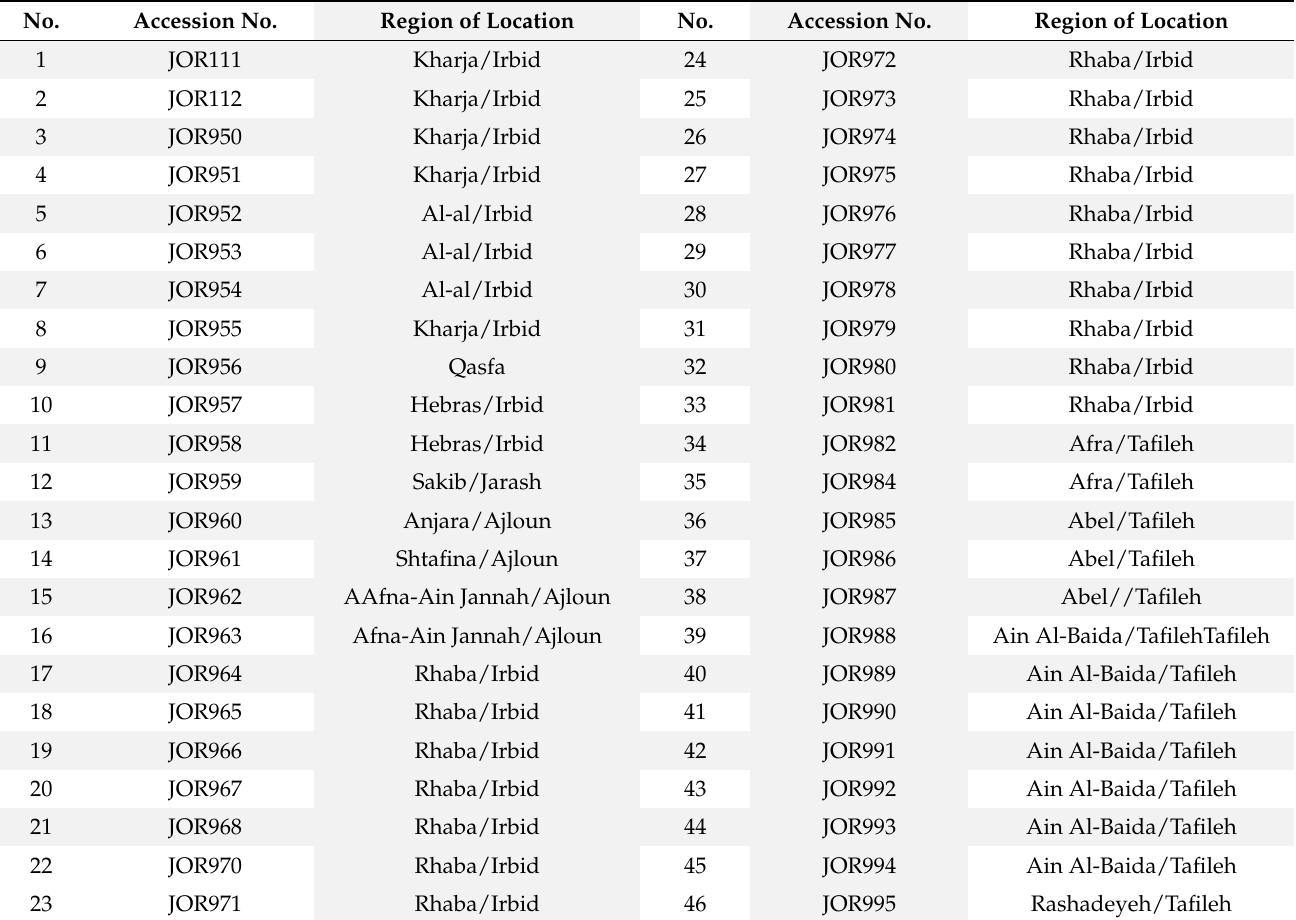
Table 1. Tomato accession collection regions used in this